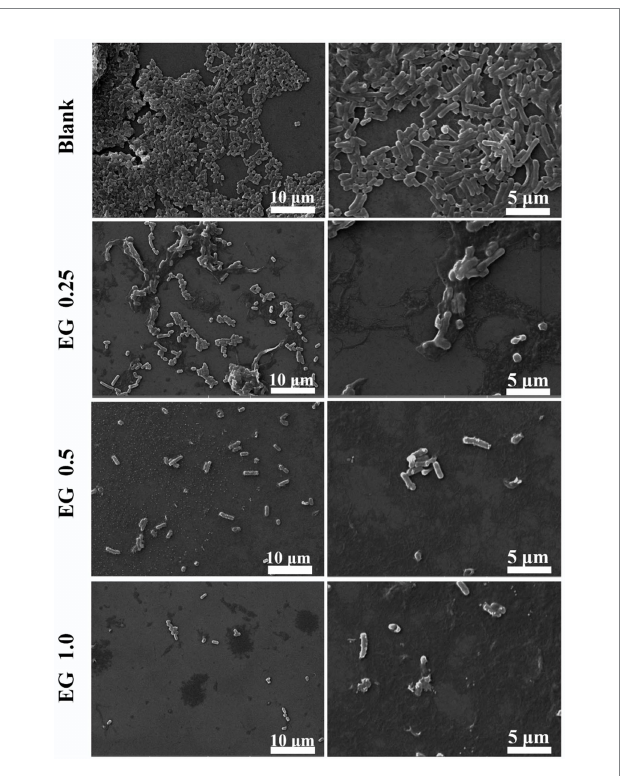
FIGURE 3 Morphology of CRKP bacteria under scanning electron microscopy (SEM) (5000 × and 10000 ×): blank and EG-treated CRKP